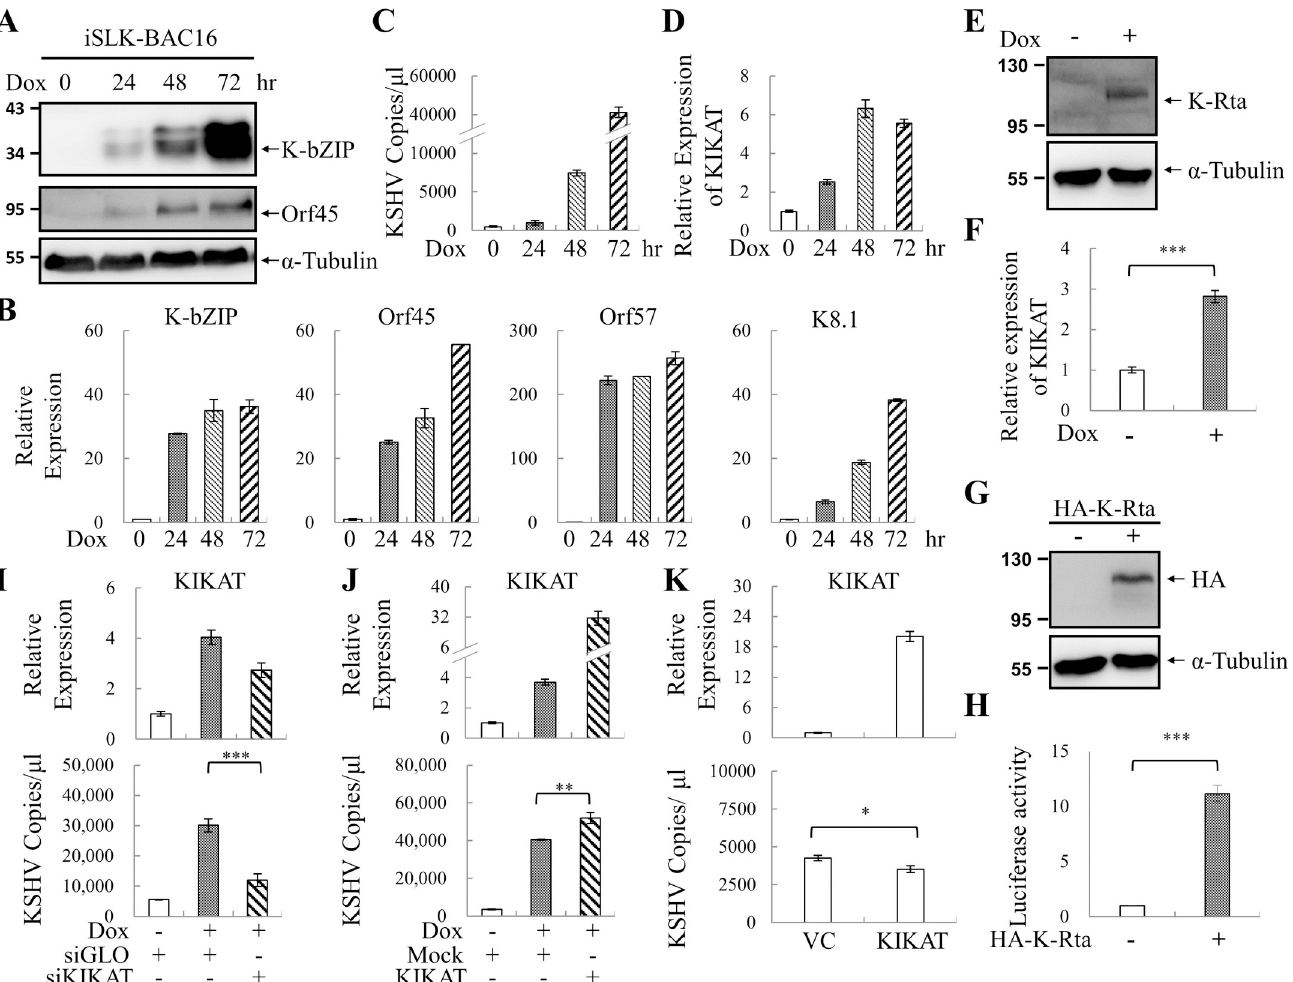
Fig 7. KIKAT/LINC01061 is important for KSHV reactivation. (A and B) Immunoblotting (A) and RT-qPCR (B) analysis of the expression of K-bZIP, Orf45, Orf57, K8.1 in iSLK-BAC16 cells treated with 1 μ g/ml Dox for 0, 24, 48 and 72 hours. (C) KSHV virion-associated DNA was determined by TaqMan qPCR. (D) Expression of KIKAT/LINC01061 was determined by RT-qPCR. (E) Immunoblotting of K-Rta in iSLK cells treated with or without Dox for 48 hours. (F) RT- qPCR analysis of KIKAT/LINC01061 in iSLK cells treated as described in (E). (G) The luciferase reporter plasmid containing KIKAT/LINC01061 promoter (TSS ± 500 bp) was co-transfected with pcDNA3-HA-K-Rta or with empty vector into 293T cells. After 48 hours, cells were collected for immunoblotting with anti- HA and anti- α -Tubulin antibodies. (H) Luciferase reporter assays were performed in 293T cells treated as described in (G). The activity of firefly luciferase was normalized to that of Renilla luciferase in the same assayed sample and reported as the relative activity of vector control. (I) iSLK-BAC16 cells were transfected with siKIKAT/LINC01061 or with control siGLO. After 6 hours, cells were re-seeded in 6-well plates and treated with 1 μ g/ml Dox for another 48 hours. Relative expression of KIKAT/LINC01061 (upper panel) and KSHV virion-associated DNA (lower panel) was determined by RT-qPCR and TaqMan qPCR, respectively. (J) iSLK-BAC16 cells were transduced with lentivirus expressing full-length KIKAT/LINC01061 or with no cDNA (Mock). After 16 hours, cells were re-seeded in 6-well plates and treated with 1 μ g/ml Dox for another 72 hours. Relative expression of KIKAT/LINC01061 (upper panel) and KSHV virion-associated DNA (lower panel) was determined as described in (I). (K) iSLK-BAC16 cells were transduced with lentivirus expressing full-length KIKAT/LINC01061 or with no cDNA (Mock). After 72 hours, relative expression of KIKAT/LINC01061 (upper panel) and KSHV virion-associated DNA (lower panel) was determined as described in (I).